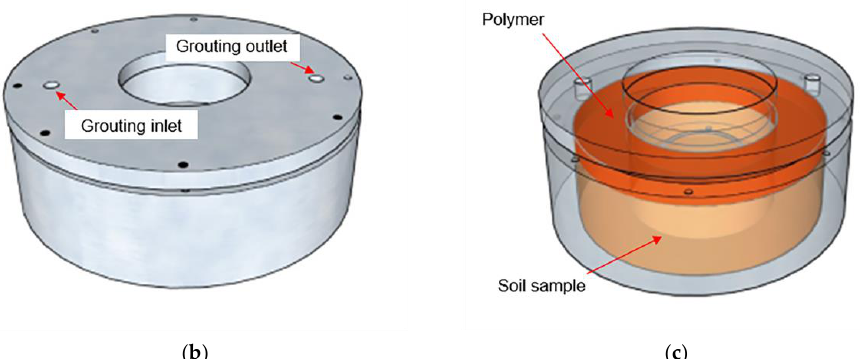
Figure 3. Polymer – soil sample mould: ( a ) section plan of the mould; ( b ) schematic diagram of the mould; ( c ) perspective drawing of the mould.